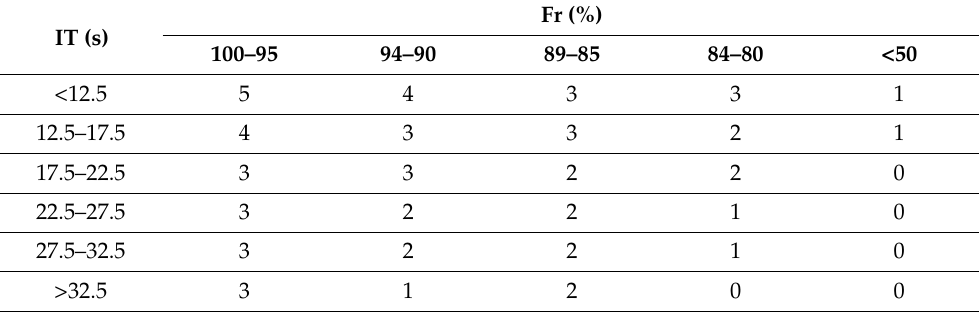
Table 1. Flammability index 1 (FI) as a function of ignition frequency (Fr) and mean ignition time